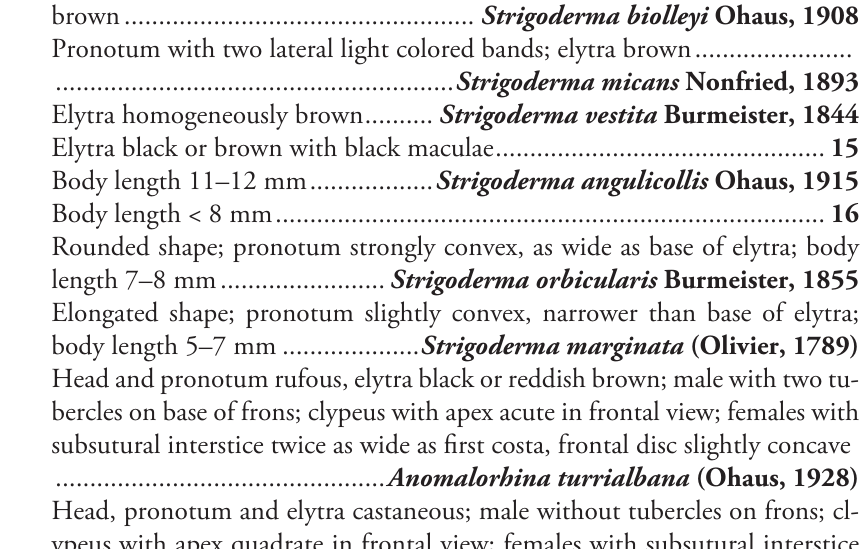
– – Body color dark brown ..... Anomala coffea Filippini, Galante, Micó, 2015 – 21 Pronotum of homogeneous color, green or brown; body length 11.0–13.0 – Pronotum dark brown with ochre sides; body length 8.5–9.5 mm; aedeagus Head and pronotum entirely black; elytra ochre with large irregular black